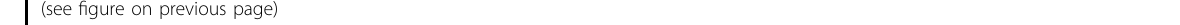
the EEG evaluation. Figure 3c illustrates a signi fi cant de fi cit in the NOR assay (delta was 8.0 s in vehicle rats vs.